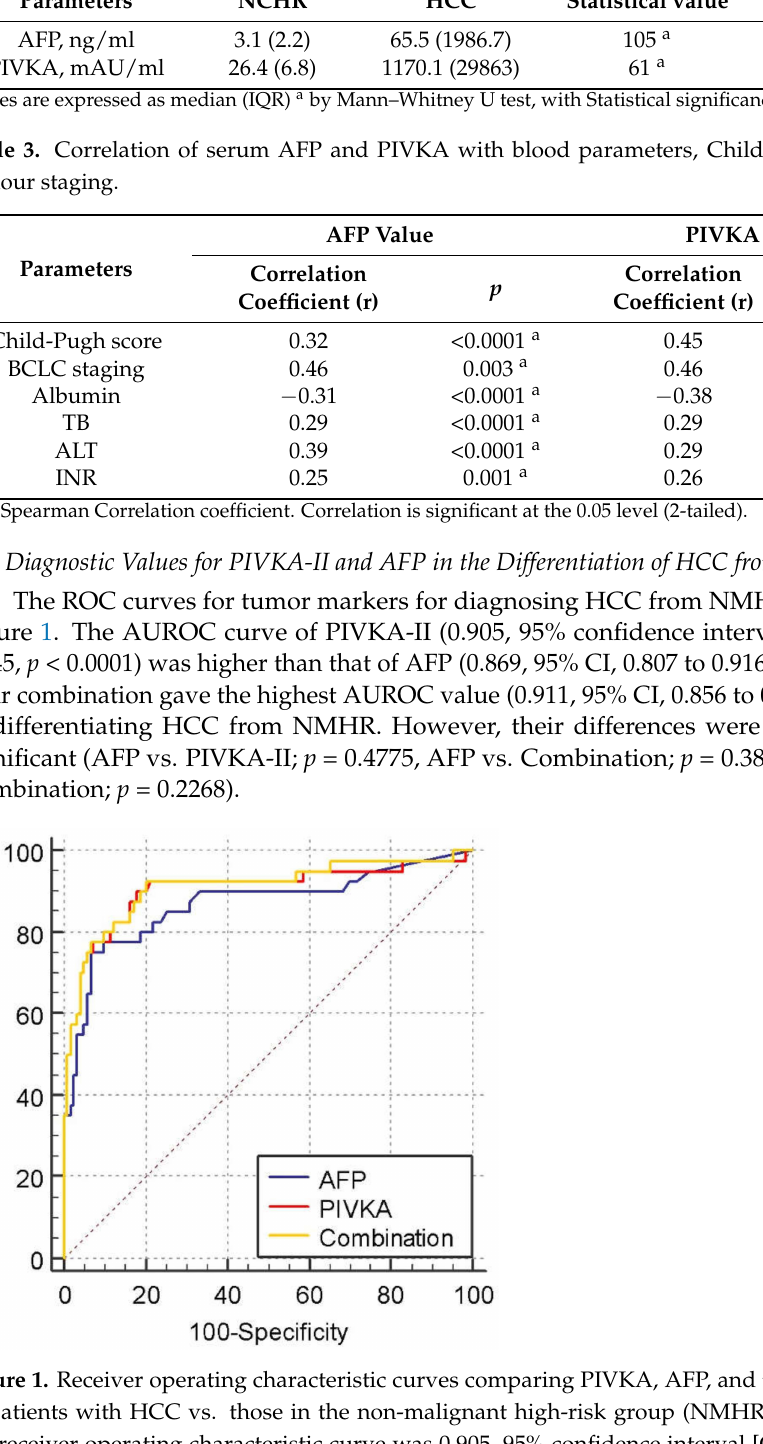
Figure 1. Receiver operating characteristic curves comparing PIVKA, AFP, and their combination in patients with HCC vs. those in the non-malignant high-risk group (NMHR). The area under the receiver operating characteristic curve was 0.905, 95% confidence interval [CI], 0.849 to 0.945, p < 0.0001 for PIVKA, 0.869, 95% CI, 0.807 to 0.916, p < 0.0001 for AFP, and 0.911, 95% CI, 0.856 to 0.950, p < 0.0001 for the combined AFP and PIVKA. p = 0.4775 for AFP vs. PIVKA-II, p = 0.2268 for Combination vs. PIVKA-II, and p = 0.3808 for Combination vs.